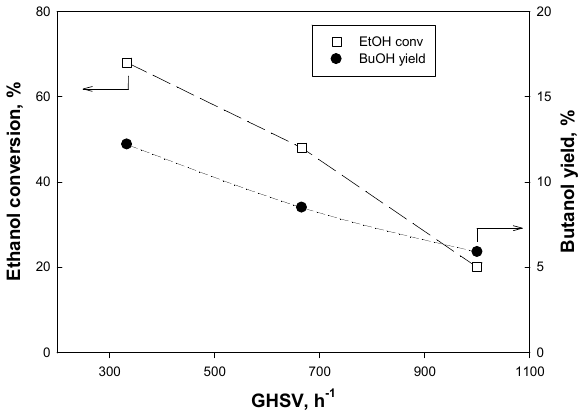
Figure 4. Ethanol conversion and butanol yield obtained in catalytic tests on 20% MgO/AC at 400 °C as a function of the gas hourly space velocity (GHSV).